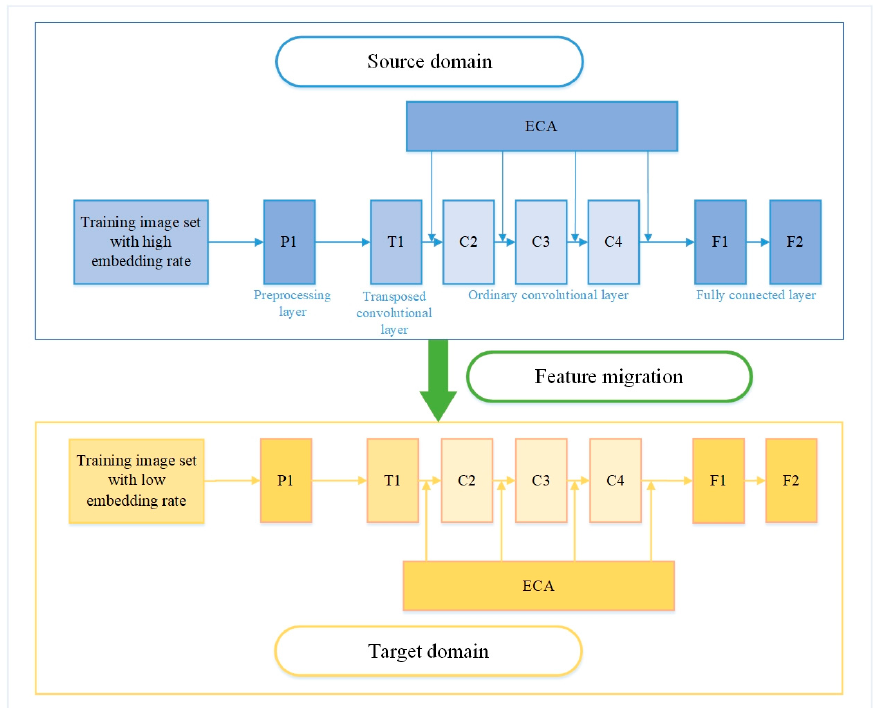
Figure 3. Detailed architecture of the transfer learning method. The top half (i.e., blue area) is the source domain and the bottom half (i.e., yellow area) is the target domain. The features are transferred to the target domain after training in the source domain.